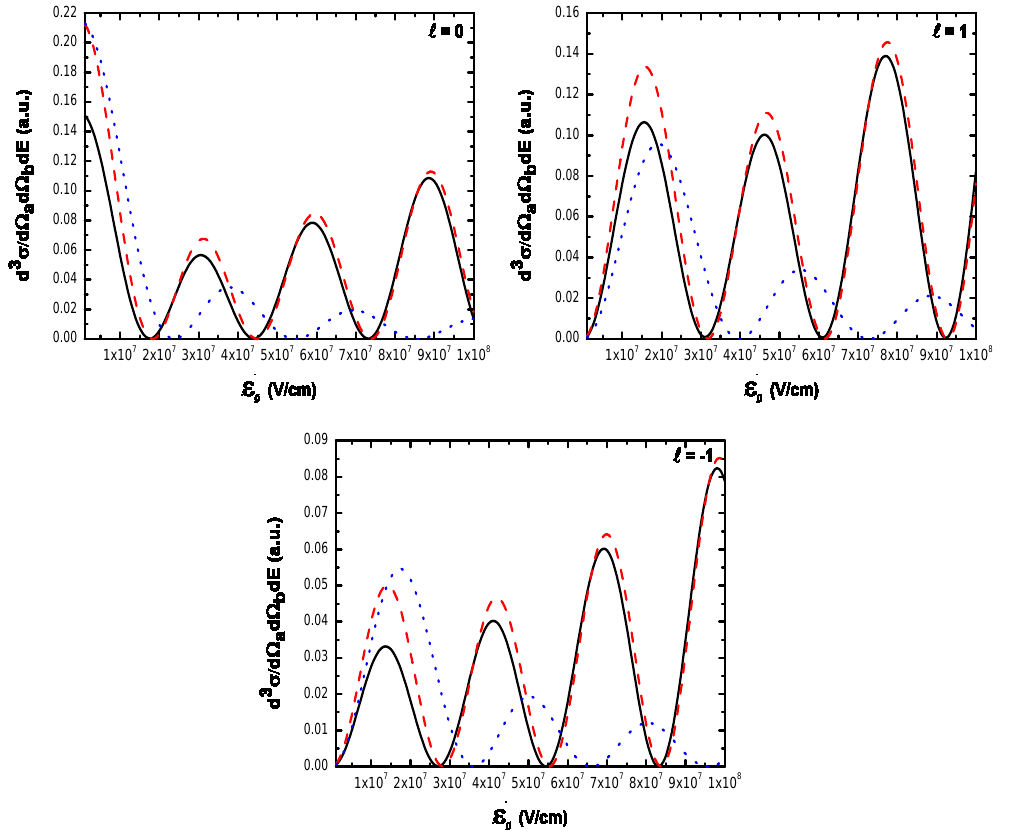
Figure 12. Triple differential cross sections corresponding to the laser-assisted electron-impact ionization process of atomic hydrogen as a function of the amplitude vector E 0 . the incident electron = 30 eV and the ejected electron energy is E = 5 eV. The scattering angle is θ a = 5 ◦ , energy is E k k b i the emission angle of the ejected electron is θ b = 130 ◦ and the laser frequency is ω = 1.17 eV. The laser polarization of the field is set parallel to the incident momentum ( ˆ ε // k i ) . : second Born approximation results. − − − : first Born approximation results. · · · · · : results obtained by neglecting the dressing of the